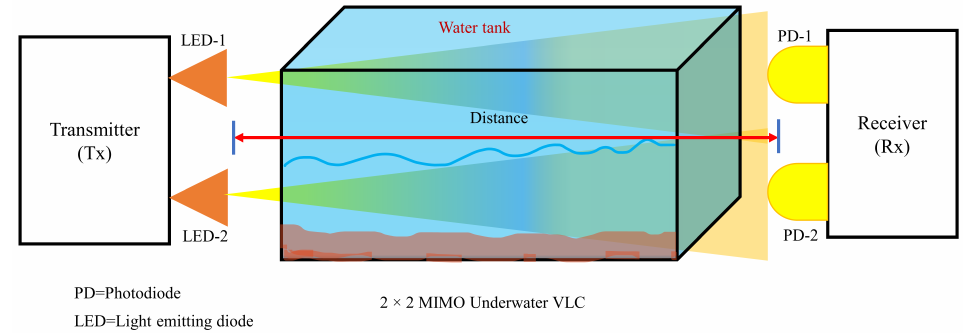
Figure 9. 2 × 2 underwater MIMO VLC